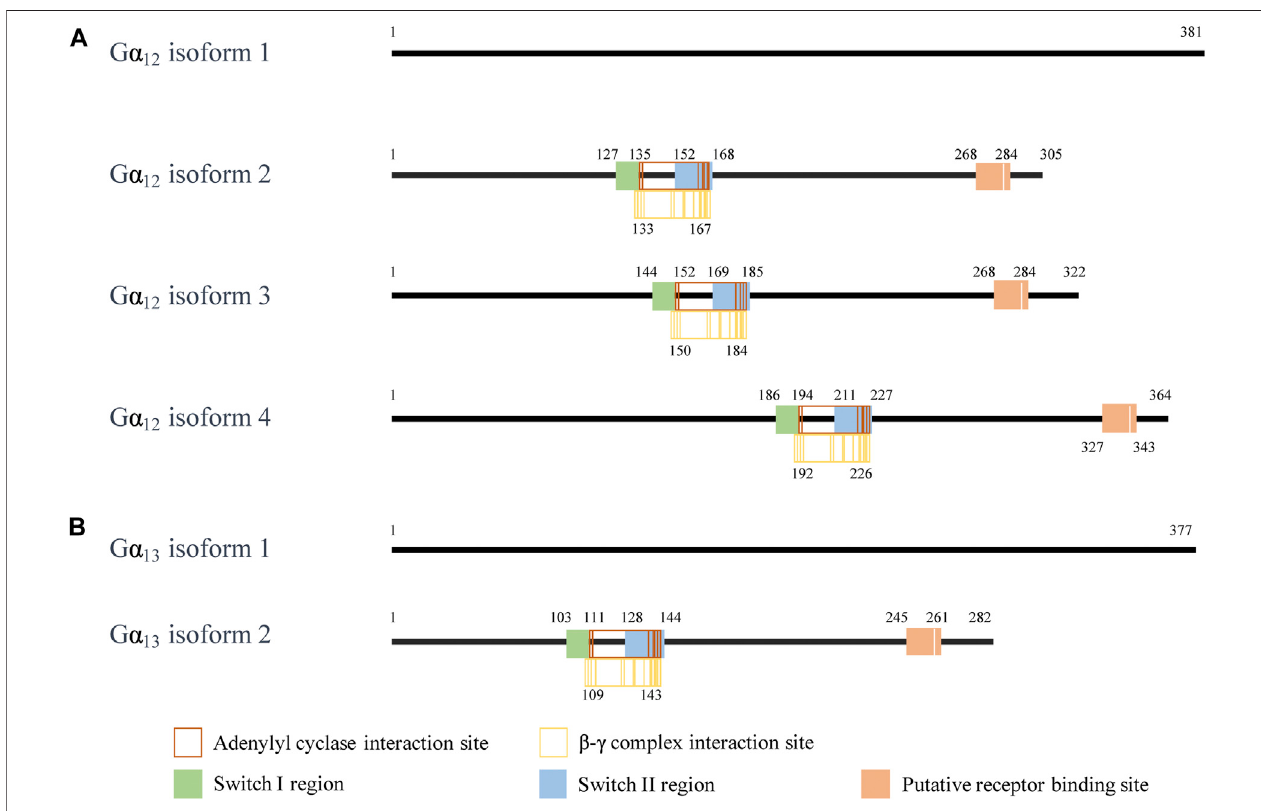
FIGURE1 | The interaction site of theG α 12/13 isoform. (A) The interaction sites onthe amino acidfragmentofG α 12 isoforms. (B) Theinteractionsites on theamino acid fragment of G α 13 isoforms. The information on the interaction sites of G α 12 and G α 13 is from NCBI. In NCBI reference sequence database, the human GNA12 isoformsareNP_031379.2,NP_001269369.1,NP_001269370.1,andNP_001280021.1.(https://www.ncbi.nlm.nih.gov/gene/2768).Thehuman GNA13 isoformsare NP_006563.2 and NP_001269354.1.